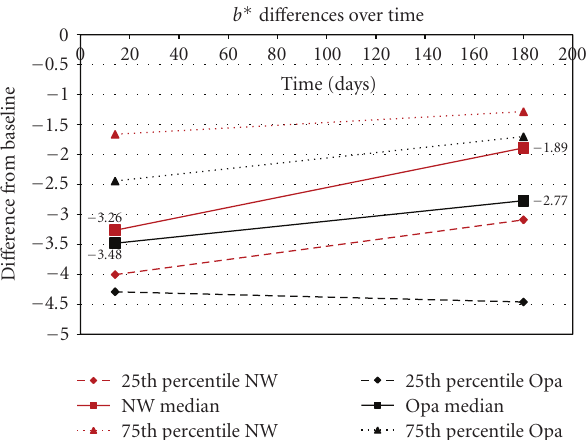
Figure 3: Opalescence (Opa) and Nite White (NW). The 25th percentile, median, and 75th percentile di ff erences in the b ∗ values between the baseline (before treatment) and after treatment (14 days) and between baseline and after 6 months.